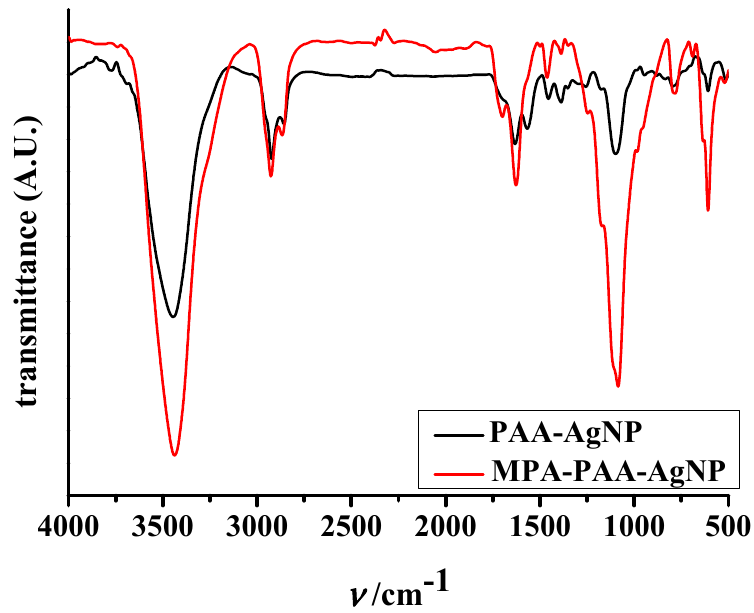
Figure 5. FTIR spectra of PAA-AgNPs and MPA-PAA-AgNPs, respectively.